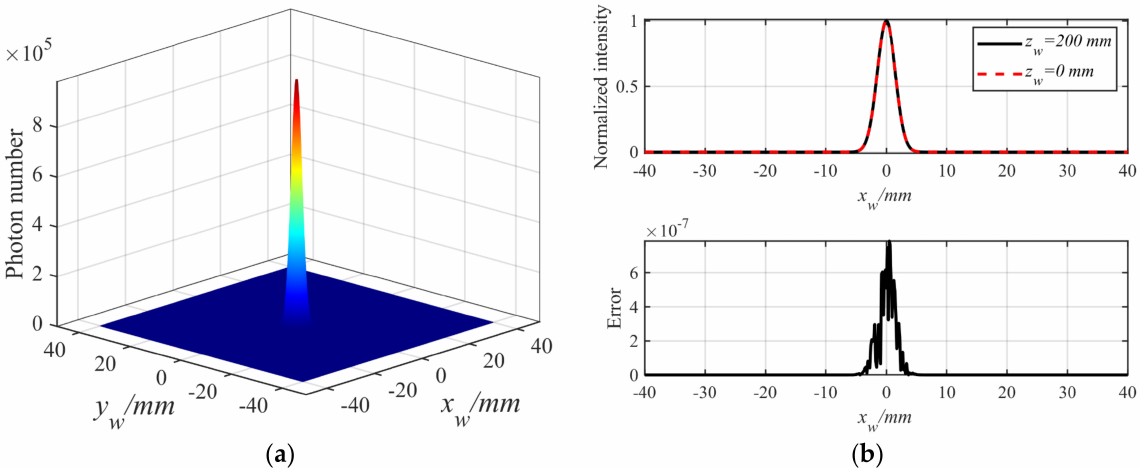
Figure 12. ( a ) Photon reception intensity in the ideal optical system; ( b ) optical calculation error in the ideal optical system.